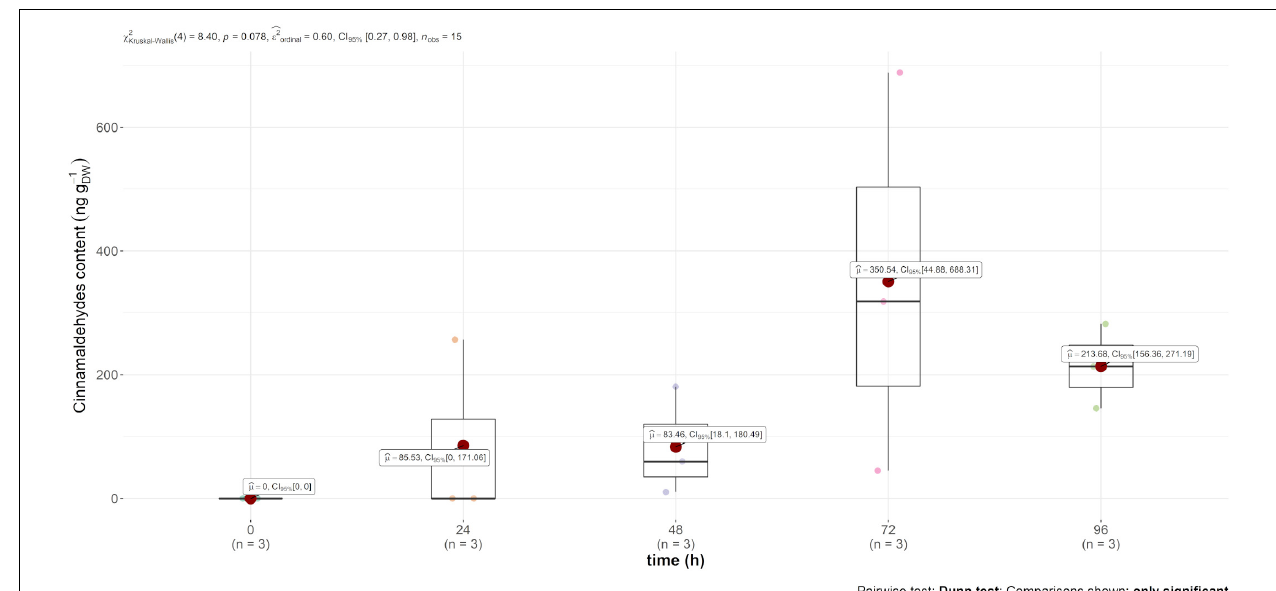
FIGURE 3 | Boxplot of trans -cinnamaldehyde contained (in ng g DW − 1 ) in the leaves over time after injection.